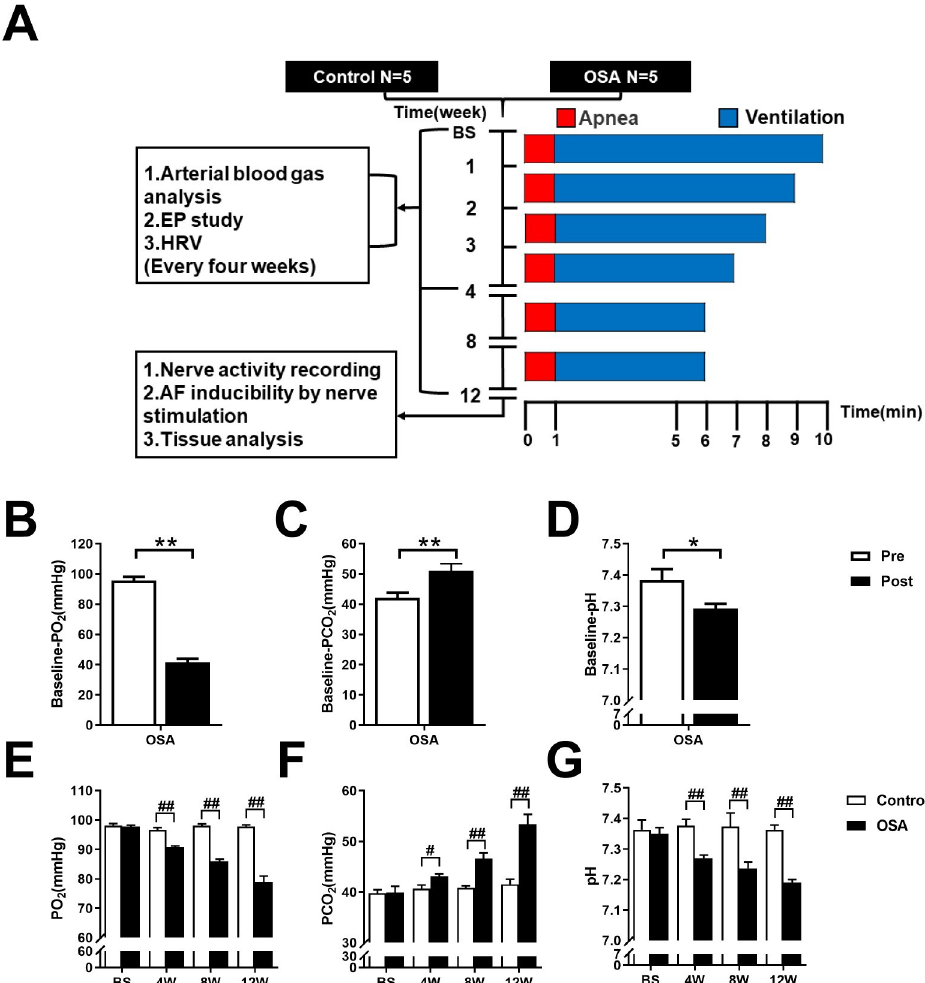
Fig 1. Flow chart of the design and analysis of arterial blood gas changes. (A) Flow chart of the study design. (B-D) Arterial blood gas analysis before and after 1 minute of apnea at baseline. (E-G) Arterial blood gas analysis between control and OSA groups at the end of the 4 th , the 8 th , and the 12 th week. Abbreviations: EP: electrical physiology; HRV: heart rate variability; Pre: preapnea; Post: postapnea. � P < 0.05, �� P < 0.01 compared to preapnea; # P < 0.05, ## P < 0.01 compared to control